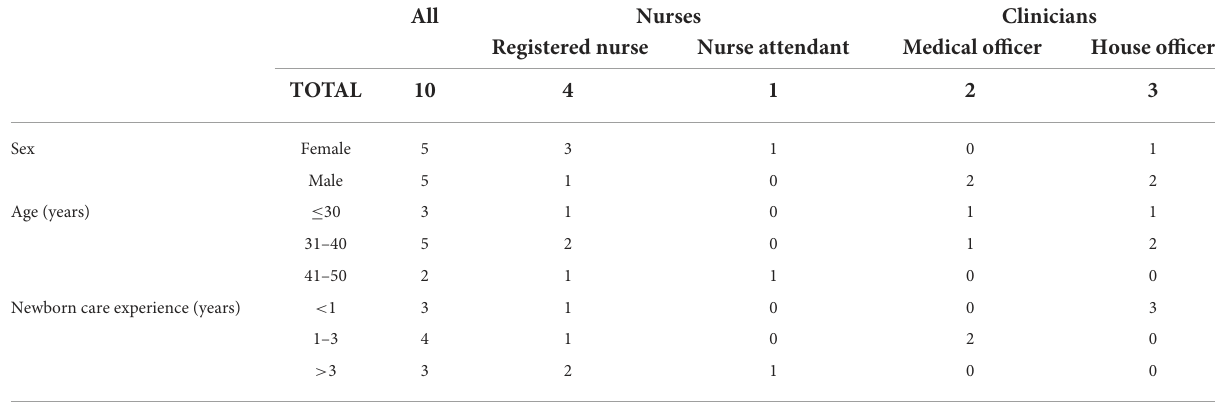
TABLE 1 Demographic and professional details of health care worker participants. All